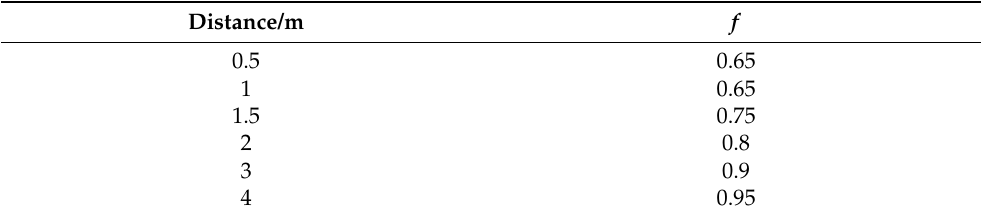
Table 1. Relationship between distance and height factor, f